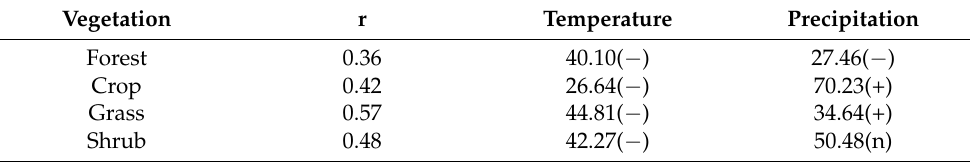
Table 3. Responses of VGT to climate change in dry seasons in Mara River Basin. Vegetation